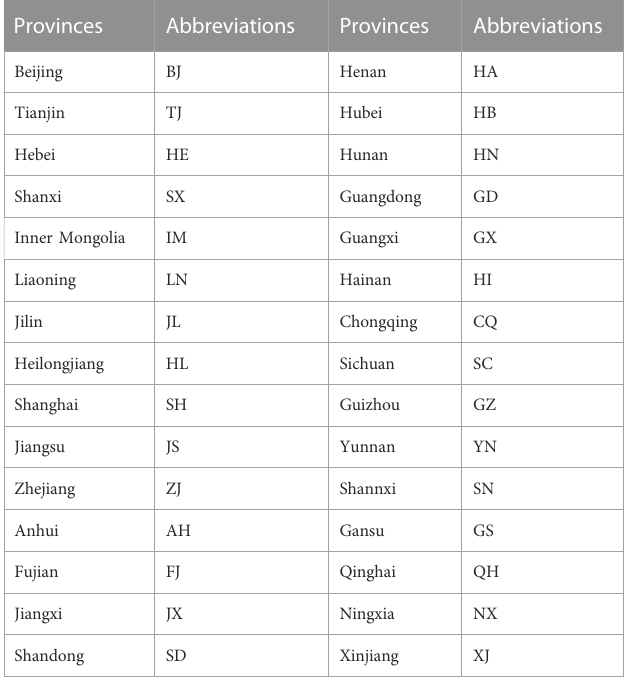
TABLE 2 Abbreviations of provinces.